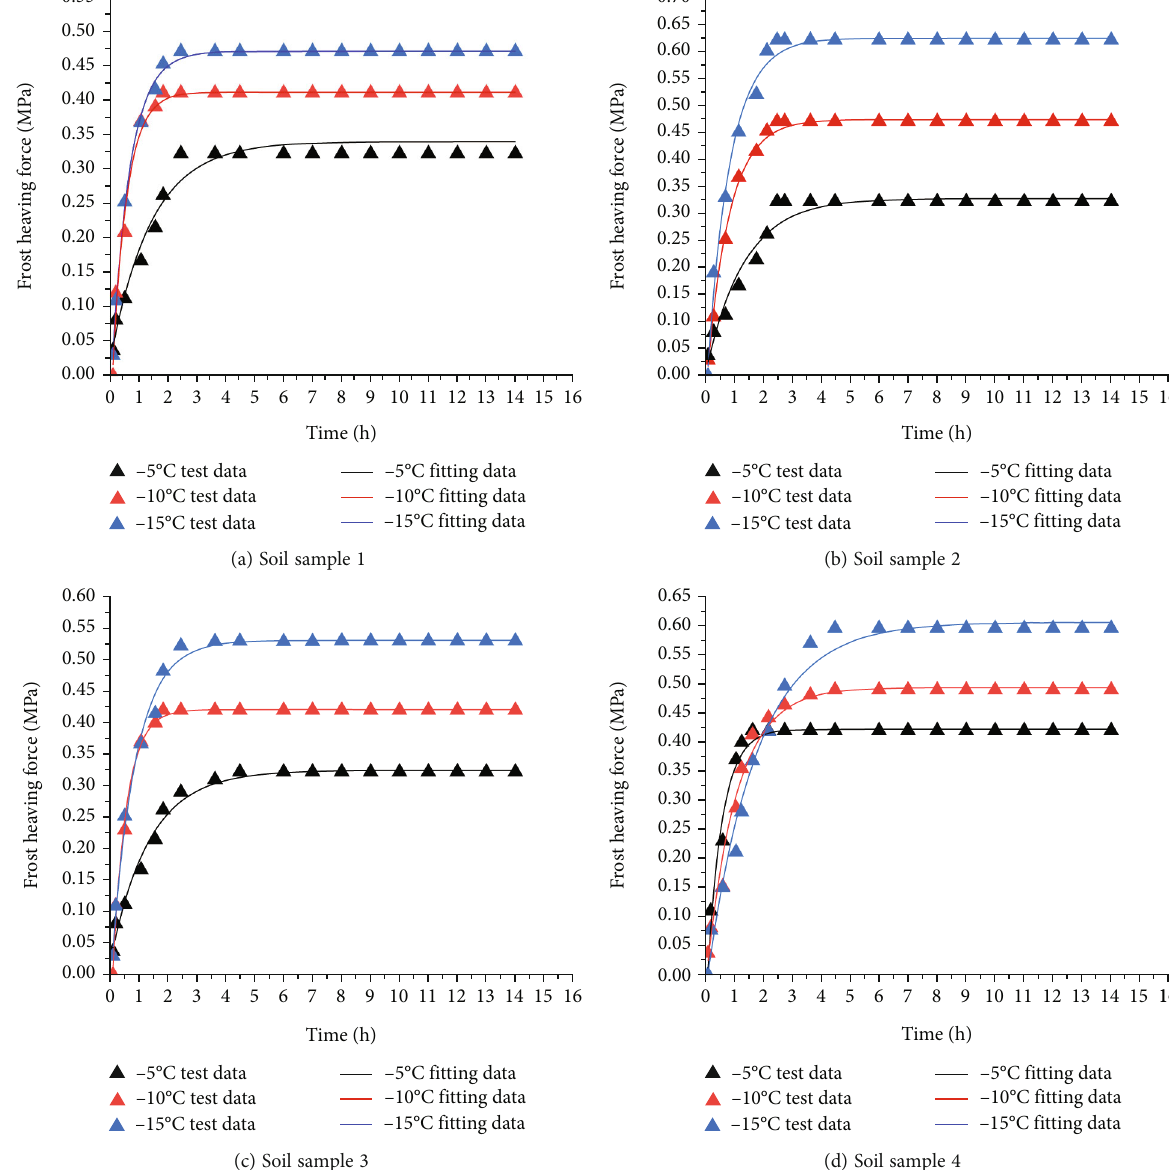
Figure 3: Relation curve between frost heaving force and